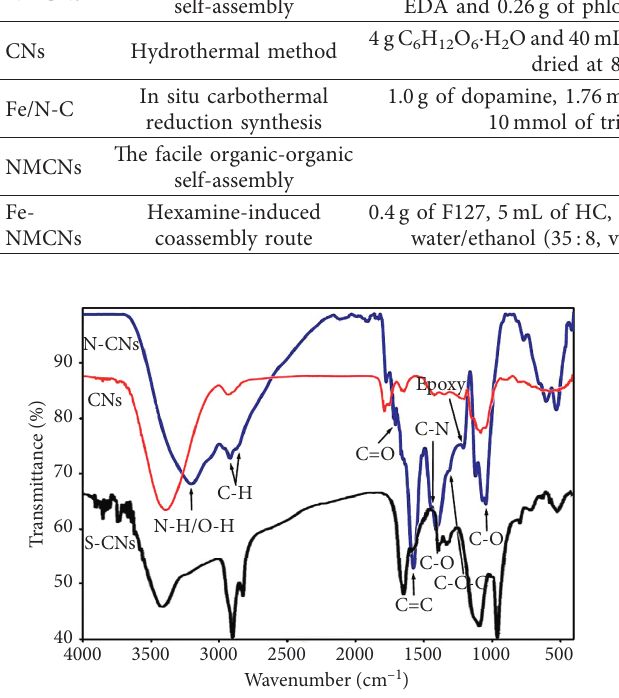
Figure 1: FTIR analysis of CNs, N-CNs, and S-CNs.